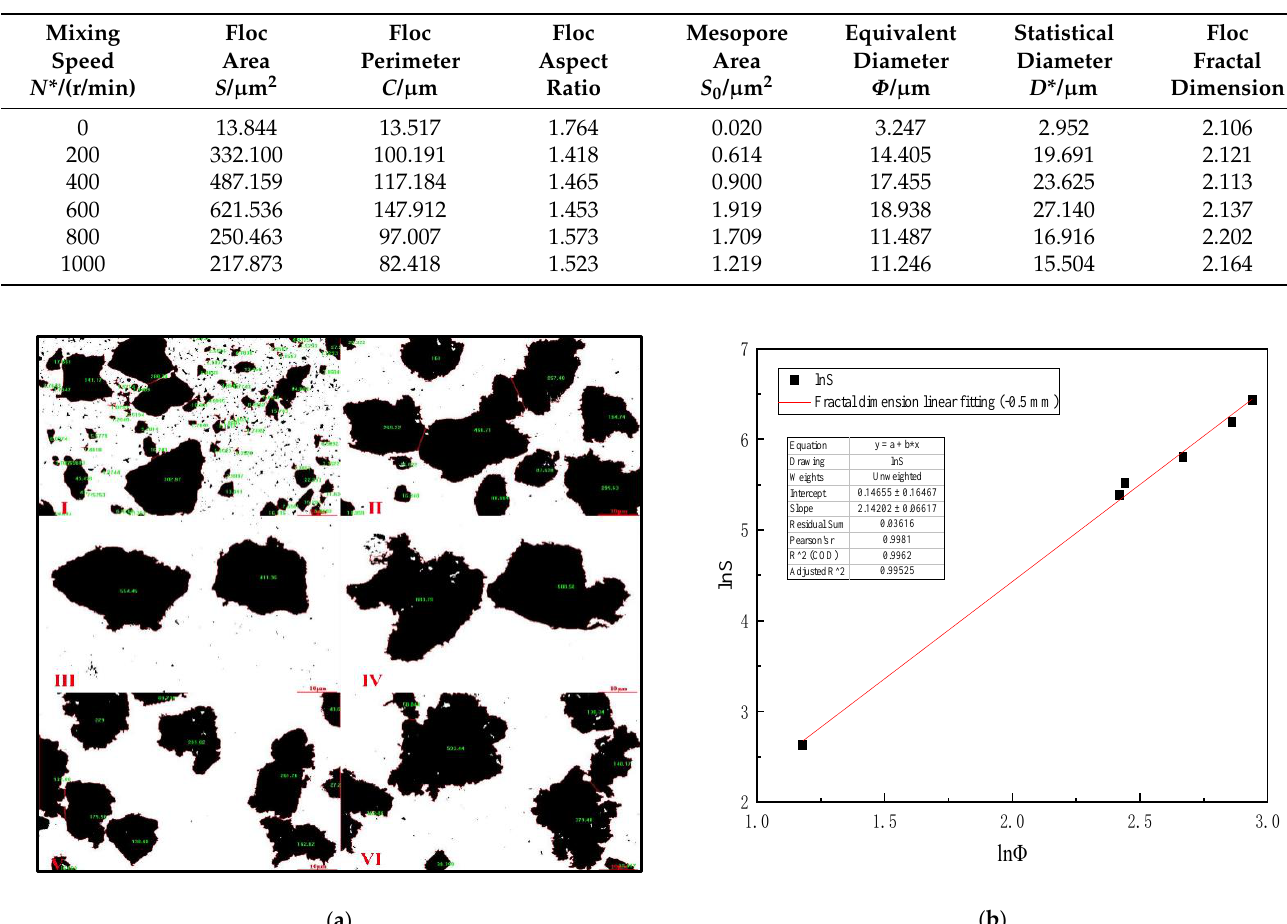
Table 5 is analyzed by Image-Pro-Plus 6.0 software and (Formulas (15)–(17)), which shows that when the mixing speed is 600 r/min, the equivalent diameter of − 0.5 mm slime settling floc is the largest, and the settling speed of slime floc is the fastest on the microscopic level. Figure 6a is the analysis diagram of floc area of − 0.5 mm slime at the mixing speed of 0–1000 r/min. Figure 6b shows the fractal dimension fitting diagram, when the mixing speed is 0–1000 r/min, the mean fractal dimension of − 0.5 mm coal slime floc is 2.142. Table 5. Mixing speed versus equivalent diameter of settling floc ( − 0.5 mm slime).